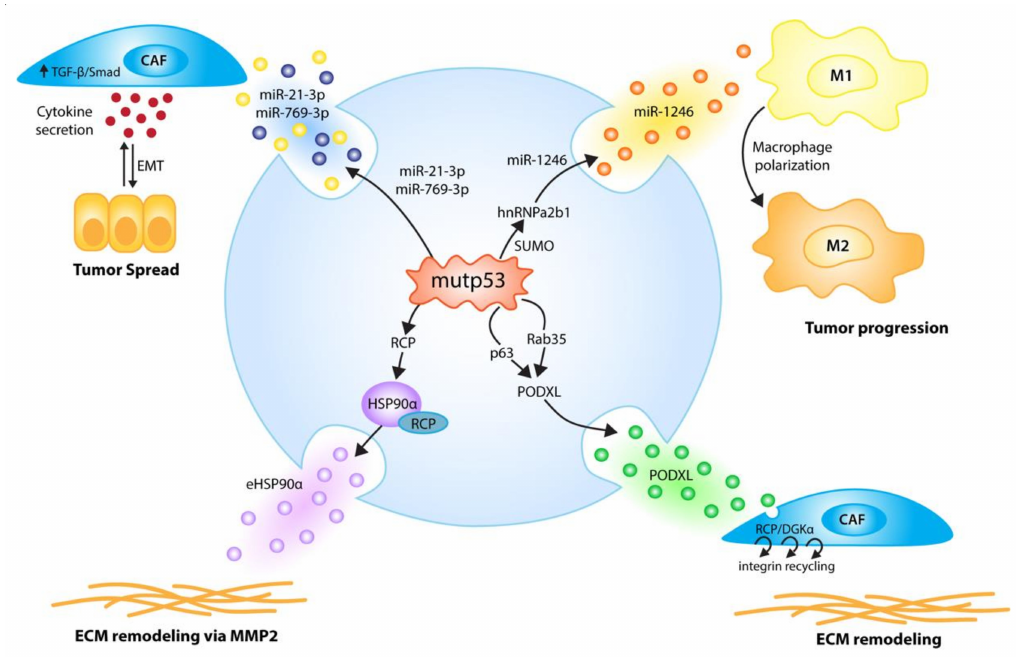
Figure 4. p53 mutants (mutp53) employ EVs to communicate signals to the host microenvironment that promote tumor growth and metastasis. p53 mutants induce the secretion of EVs enriched in selected miRNAs; miR-1246-enriched EVs, due to hnRNPa2b1 SUMOylation, reprogram macrophages to a tumor-supporting M2-like phenotype [67], while the mutp53-induced secretion of miR-21-3p / miR-769-3p EVs activates cancer-associated fibroblasts (CAFs) to secrete cytokines and enhance tumor cell motility via an epithelial-to-mesenchymal transition (EMT) [106]. Via p63 and Rab35, p53 mutants fine-tune exosomal PODXL levels, thereby increasing RCP / DGK α -dependent, pro-invasive integrin recycling in recipient tumor cells and fibroblasts, which leads to enhanced invasion and creates pro-invasive extracellular matrix (ECM) alterations in distant organs resembling pre-metastatic niches [107]. p53 DNA contact mutants, via RCP, increase exosomal HSP90 α secretion, leading to pro-metastatic extracellular matrix remodeling via MMP2